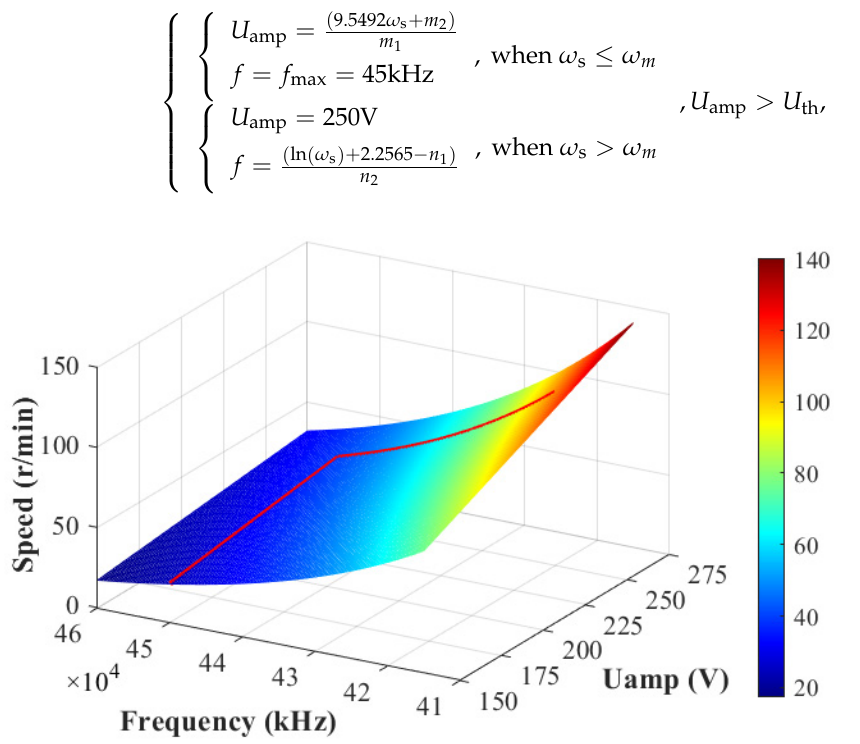
Figure 3. TWUSM speed, depending on the amplitude of voltage and frequency. As shown in Figure 3, the speed regulation curve is designed as the red line. The results of parameters identification are m 1 = 0.1547, m 2 = 2.83, n 1 = 18.47, and n 2 = 0.331. The above design process is summarized in Figure